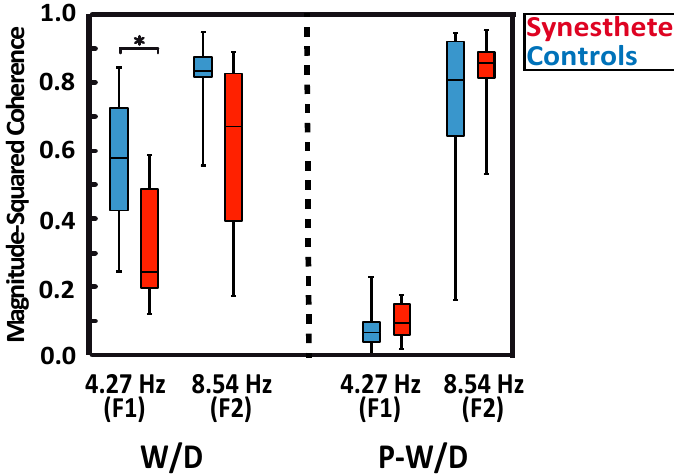
Figure 2. Magnitude-squared coherence (MSC) of ssVEPs responses in synesthetic participants (red), and control participants (blue). The whiskers indicate the minimum and maximum range of the distributions, the top and bottom of the boxes show the first and third quartiles (25th and 75th percentile), and horizontal bars inside the boxes represent the medians.